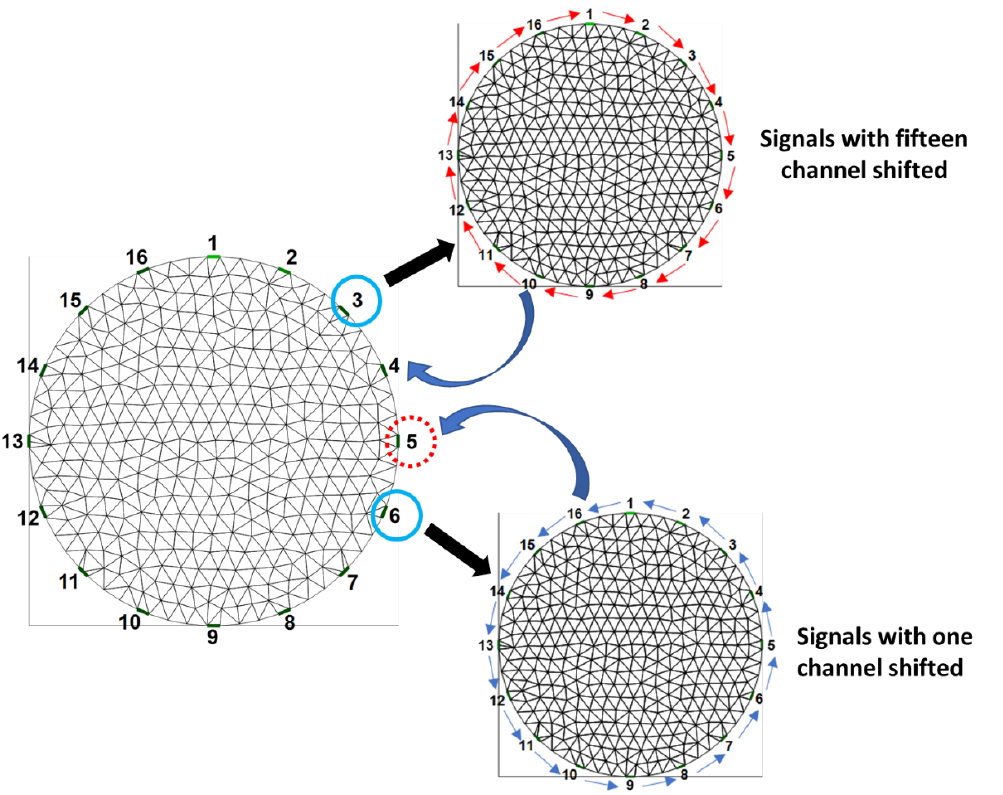
Figure 6. Illustration of voltage-shift method.